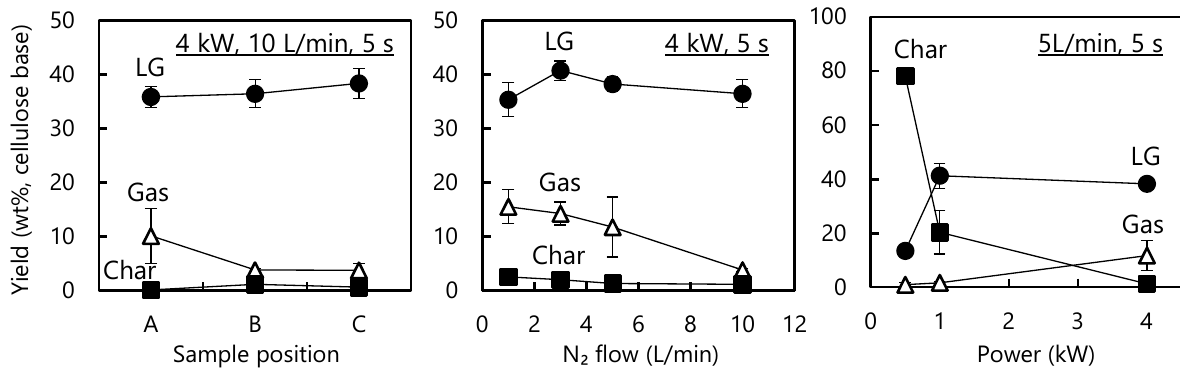
Figure 4. Effects of experimental parameters on the yields of levoglucosan (LG), gas and char from the pyrolysis of Whatman cellulose.